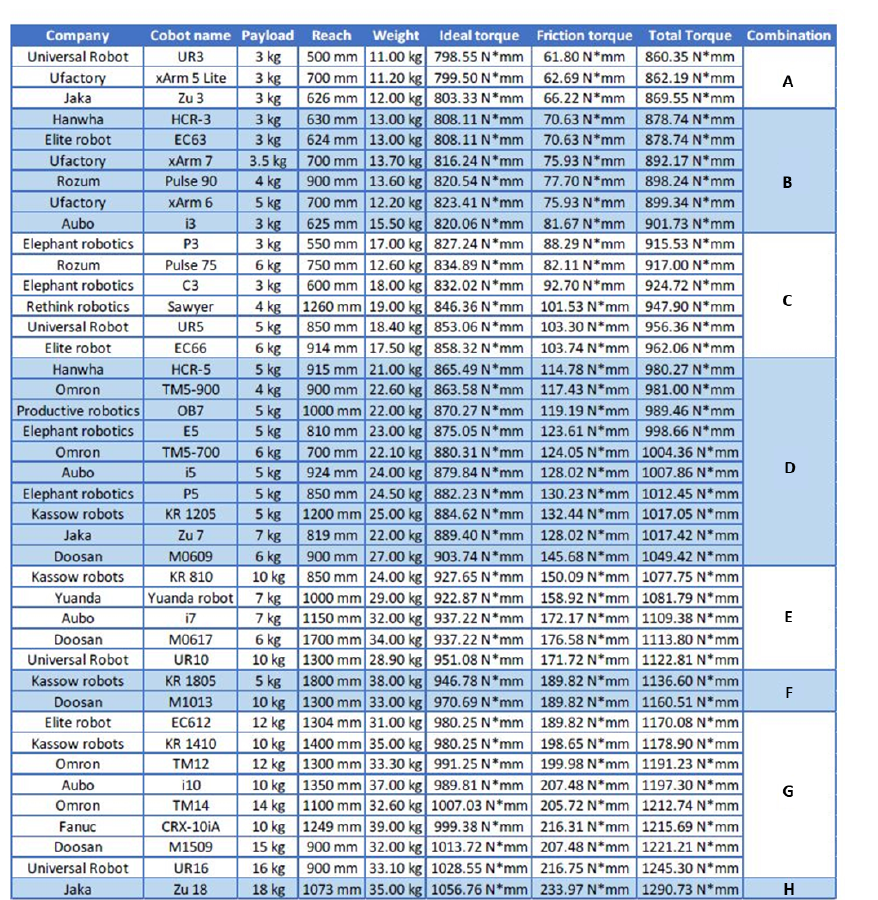
Figure 14. Combinations of motor and gearbox.